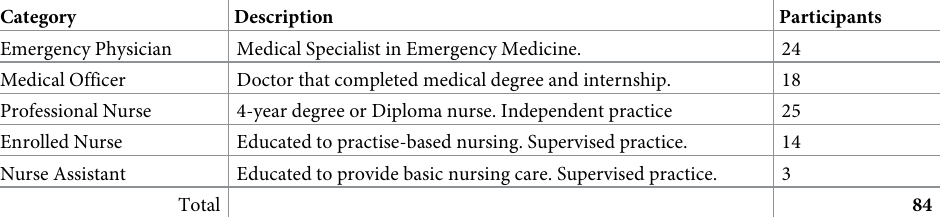
Table 1. Breakdown of participants within doctor and nurse categories.